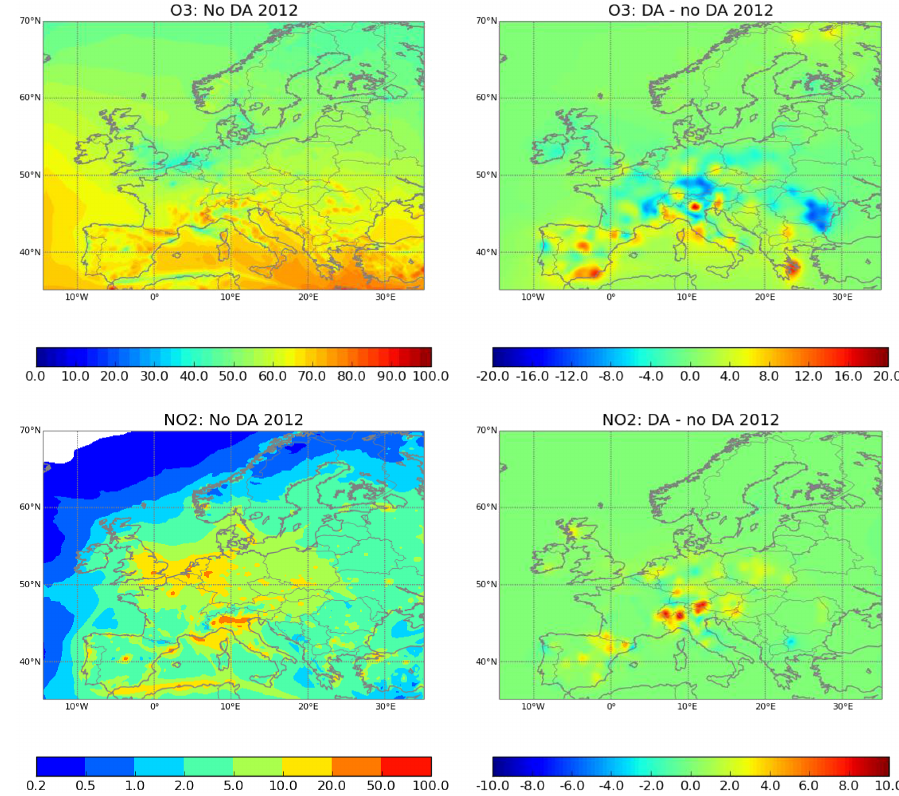
Figure 3. Yearly mean concentration (µgm − 3 , left-hand panels) on lowest model layer and difference (assimilated – not assimilated, right- hand panels) due to assimilation of O 3 (top panels) and NO 2 (bottom